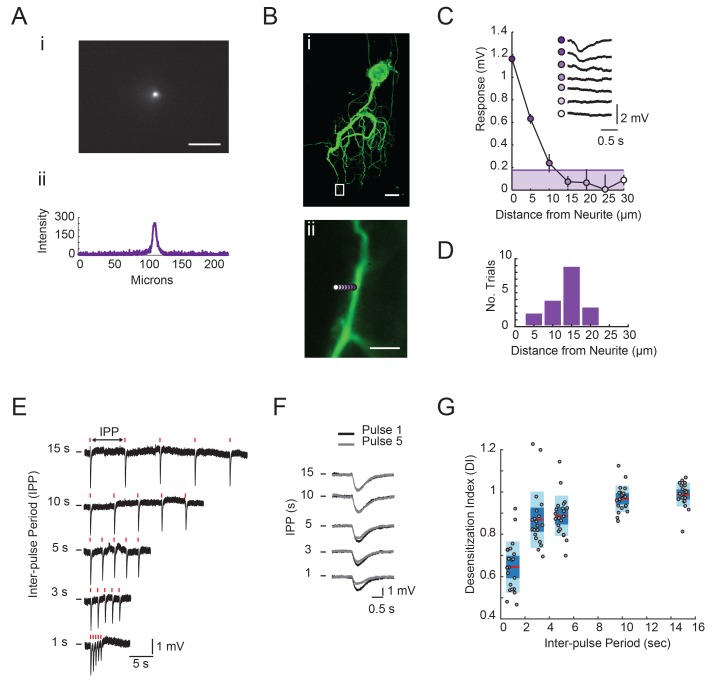
Focal glutamate photo-uncaging resolution and response desensitization.(A) Image of UV spot emission in fluorescein solution (top). Line intensity. profile (bottom) shows a saturated spot diameter of ~15 microns. (B) (i) Maximum projection of a confocal image stack of Lucifer yellow dye-filled GM neuron (20x magnification). (ii) Boxed region from (i) with UV spot photo-uncaging positions indicated with purple, with opacity that decreases with distance. (C) Plot of response amplitude (inverted) as a function of distance form neurite. (as indicated in Bii). Inset shows raw responses at each position. Line and shaded area denote 15% maximum response amplitude cut-off used to generate histogram in D. (D) Histogram showing the distance from neurite at which the response amplitude was <15% of the maximum response at a given position. Y-axis is the number of trials or positions (n = 18) sampled across 11 different STG neurons. Scale bars in A and B are 50 microns. (E) Raw traces of focal glutamate responses evoked at one position on a single GM neuron with varying inter-pulse periods (IPPs). 1 ms, 30 mW stimuli are times are indicated with red lines above traces. (F) Overlaid responses from first (black) and fifth (gray) pulses in stimulus trains shown in E. In E and F, horizontal bars indicate starting membrane potential of −40 mV. Desensitization indices (DI) were calculated by dividing the peak amplitude of the response to the fifth pulse in the stimulus train (gray) by the peak amplitude of the response to the first pulse in the stimulus train (black). A DI = 1 indicates no desensitization. (G) DI as a function of inter-pulse period across 22 photo-uncaging sites in five different neurons. Red lines indicate the median. DI values, dark blue shaded boxes indicate the standard deviations, and light blue boxes indicate the 95% confidence intervals.